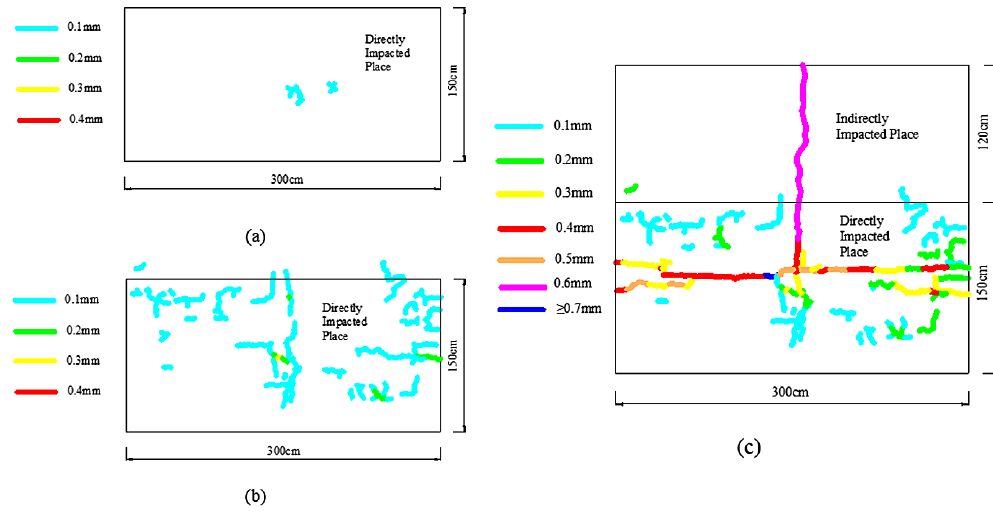
Figure 4. Distribution of the cracks on the element in series B ( a , b and c represent the B1, B2 and B3, respectively).